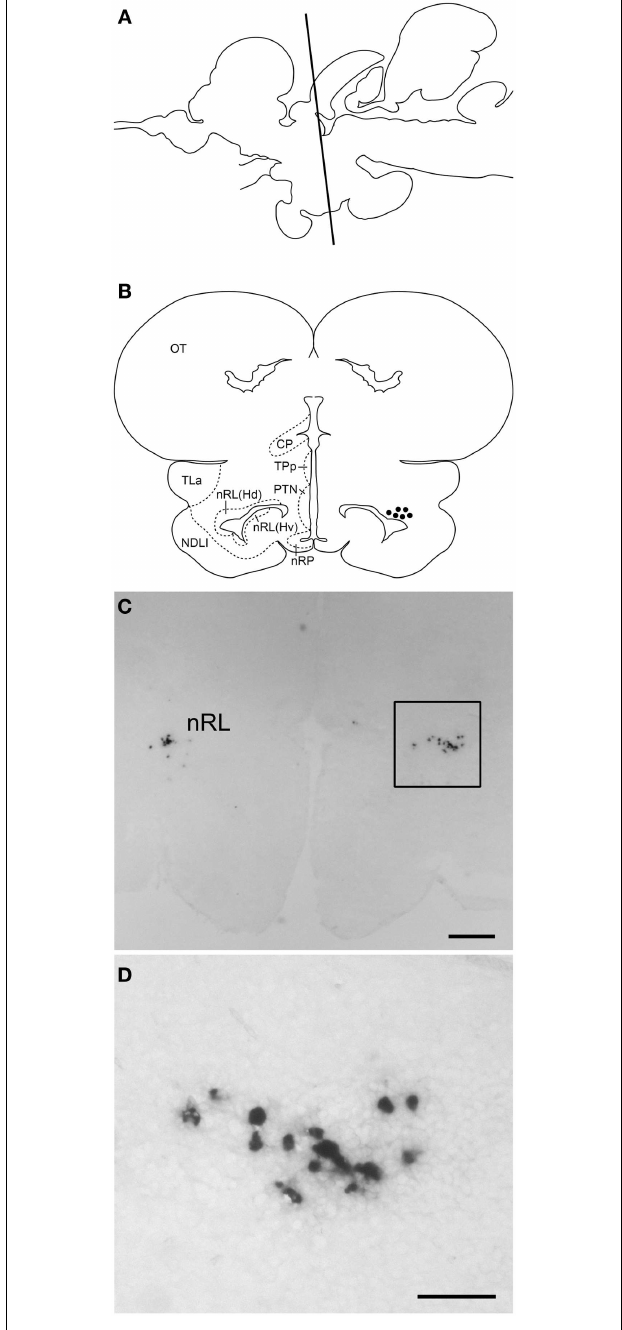
FIGURE 4 | kiss2 mRNA containing cells in the brain of male tilapia . (A) Schematic drawing of a lateral view of the brain indicating levels of the corresponding transverse section. (B) Schematic drawing of transverse section of kiss2 cells (closed circles). (C,D) Photomicrographs of DIG-labeled kiss2 cells in the nucleus of lateral recesses (nRL) at (C) Low- and (D) high-magnification. CP, central posterior thalamic nucleus; Hd, dorsal zone of periventricular hypothalamus; Hv, ventral zone of periventricular hypothalamus; NDLI, diffuse nucleus of the inferior lobe; nRP, nucleus of posterior recess; OT, optic tectum; PTN, posterior tuberal nucleus;TLa, torus lateralis;TPp, periventricular nucleus of posterior tuberculum. Scale bars: ( C) 200 µ m; (D) 50 µ